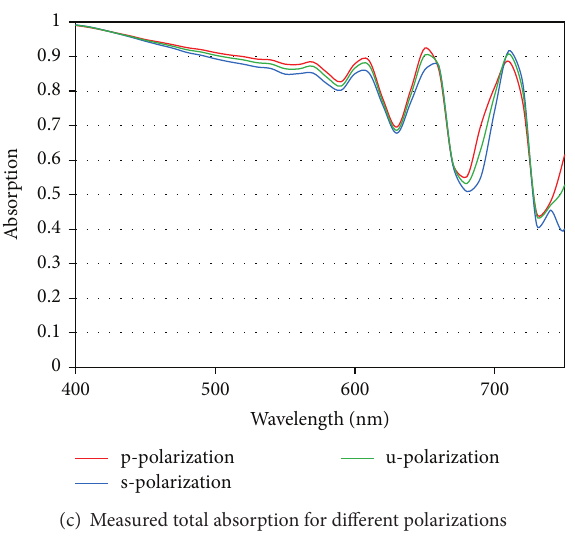
(a) Measured total absorption with and without the fishnet (b) Measured total absorption for four different samples